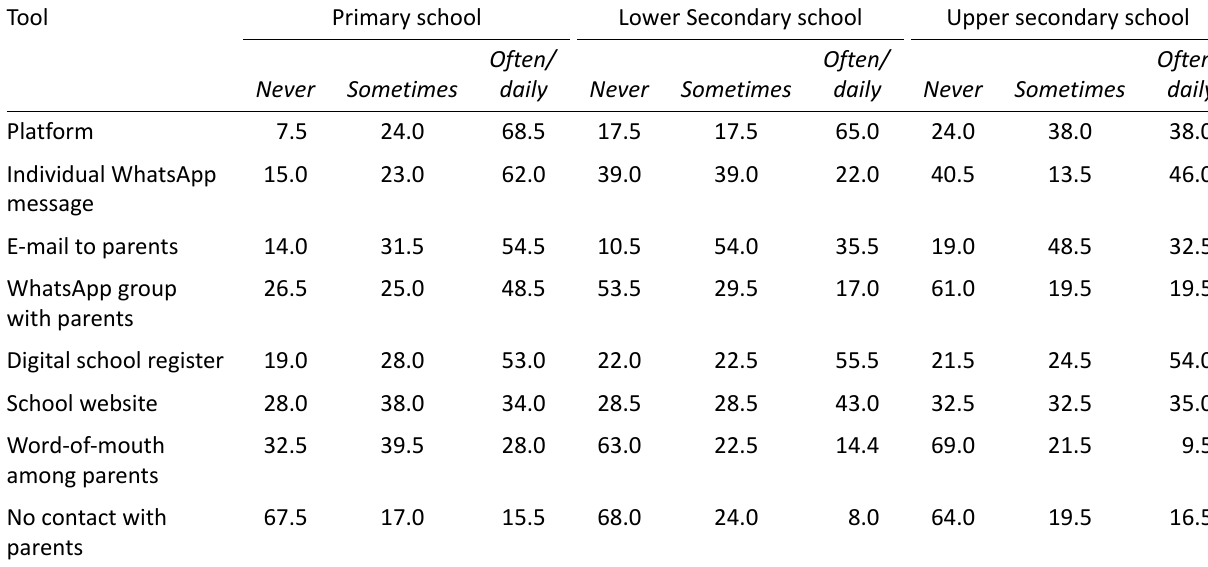
Table 2. Tools adopted by teachers to remain in contact with families of students with disabilities.